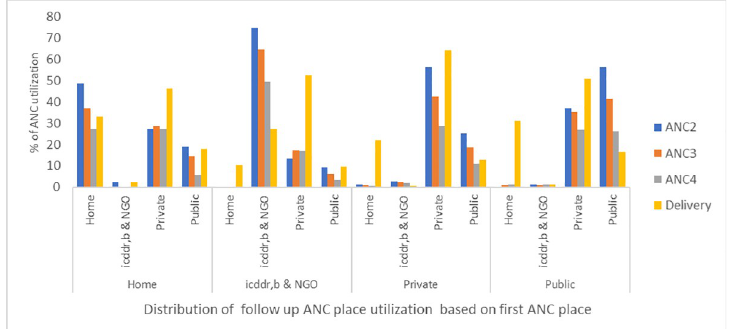
Fig 2. Patterns of health facility use for subsequent antenatal and delivery care based on the place of the first antenatal care visit.